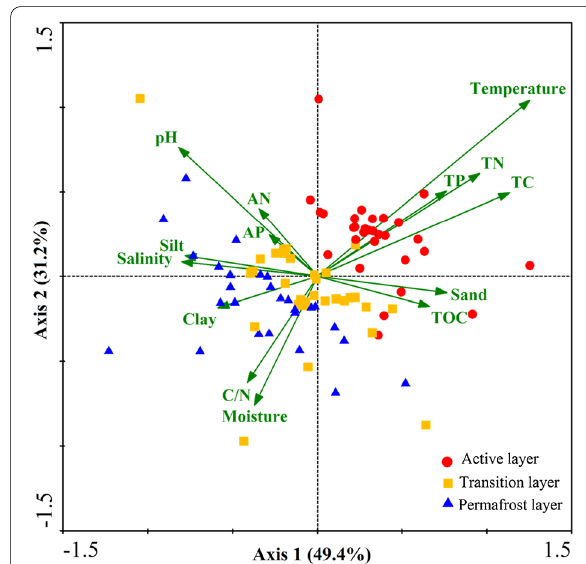
Fig. 6 Redundancy analysis based on the microbial community structures and environmental factors. (TC, soil total carbon; TN, soil total nitrogen; TP, soil total phosphorus; C/N, soil C:N; TOC: soil total organic carbon; AN: soil available nitrogen; AP, soil available